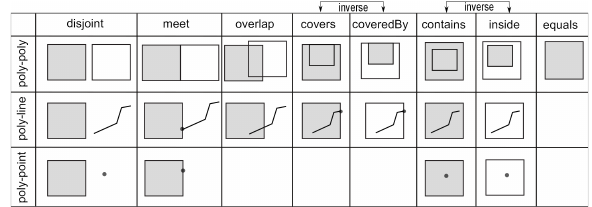
Figure 4: The 8 topological relations of the 9-Intersection